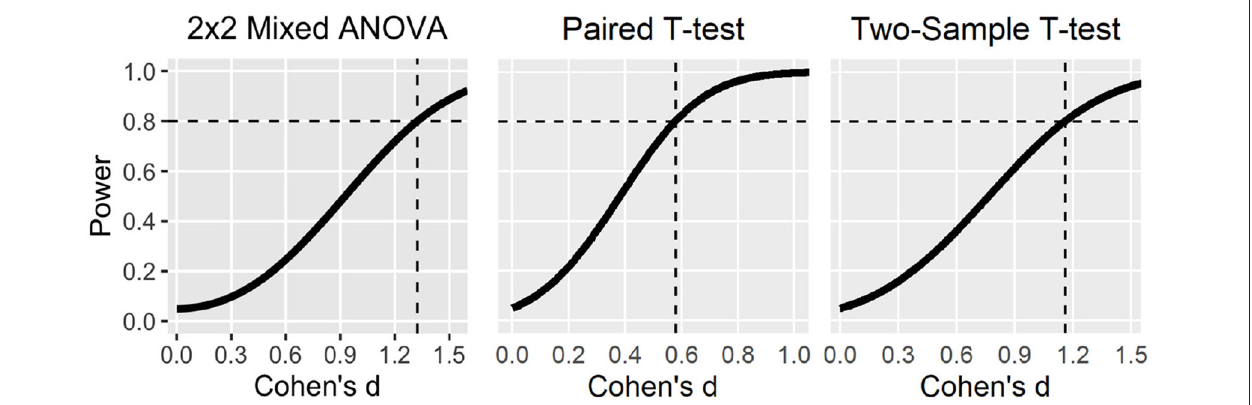
FIGURE 4 | Statistical power curves to detect different effect sizes with 20 participants (median sample size) for different statistical tests. Dashed lines indicate smallest effect sizes detectable at 80% power. Note that the power curve for the 2 × 2 mixed ANOVA was based on liberal statistical assumptions (e.g., high correlation among repeated measures, sphericity, and uncorrected p -value of